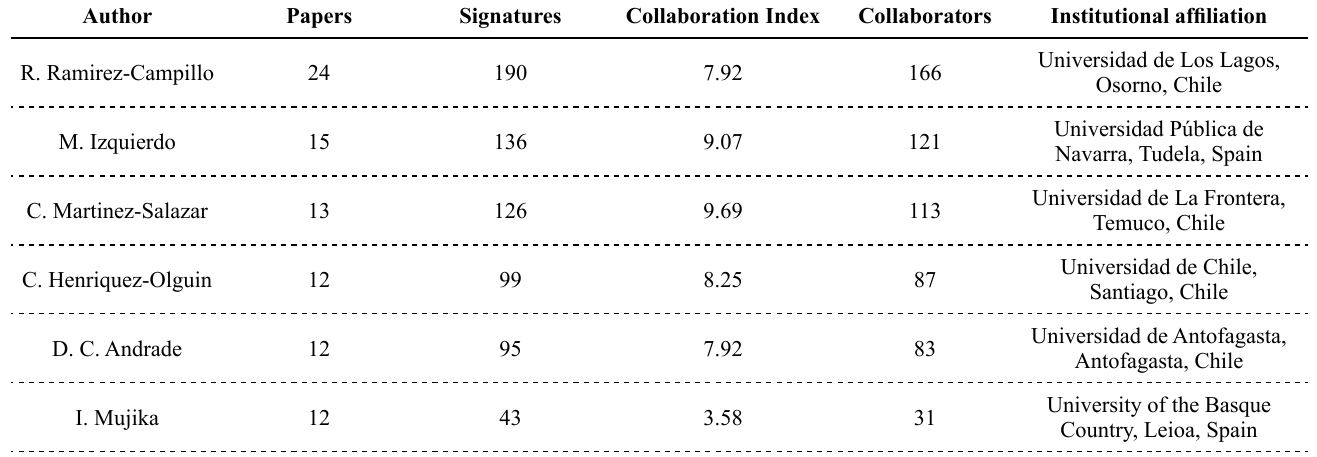
Table 4- List of most productive authors (≥6 papers), with institutional affiliations and collaboration